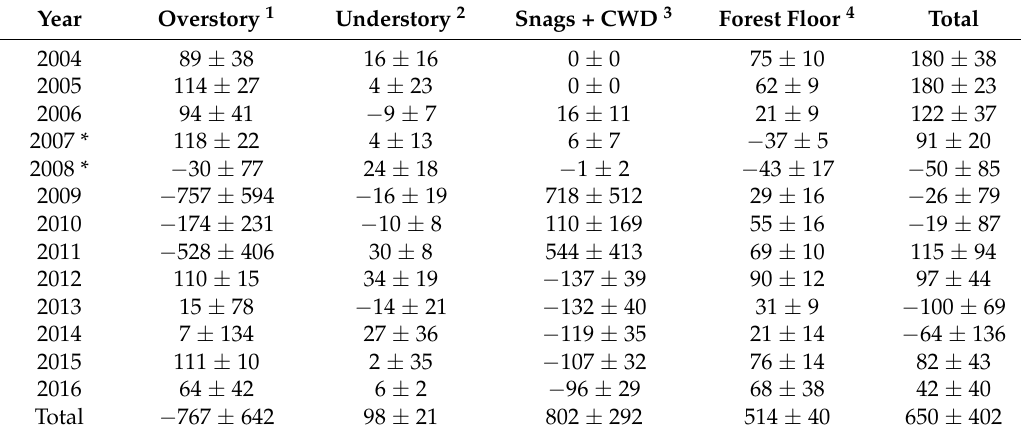
Table A4. Annual increment of woody stems of trees and saplings in the overstory, stem increment of understory shrubs and scrub oaks, net change of snags and coarse woody debris (CWD), and net accumulation of forest floor in tower plots at the oak stand from 2004 to 2016. All units